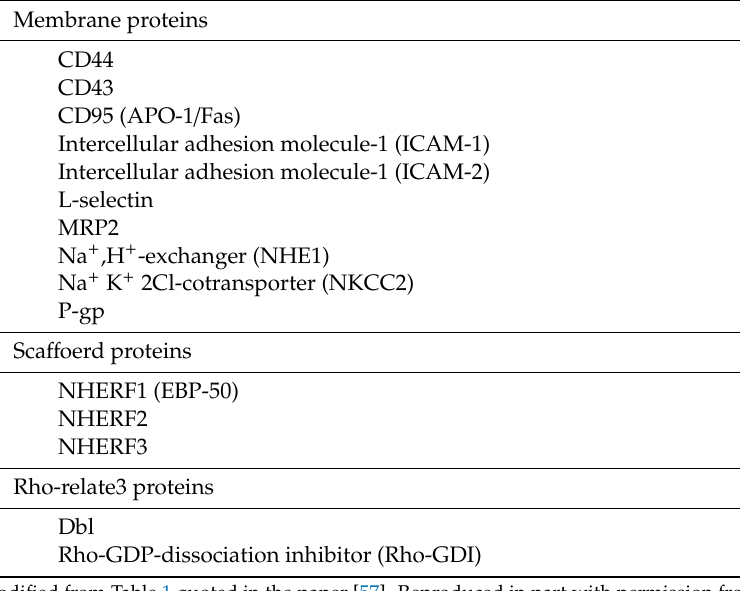
Table 1. Proteins which bind to the FERM